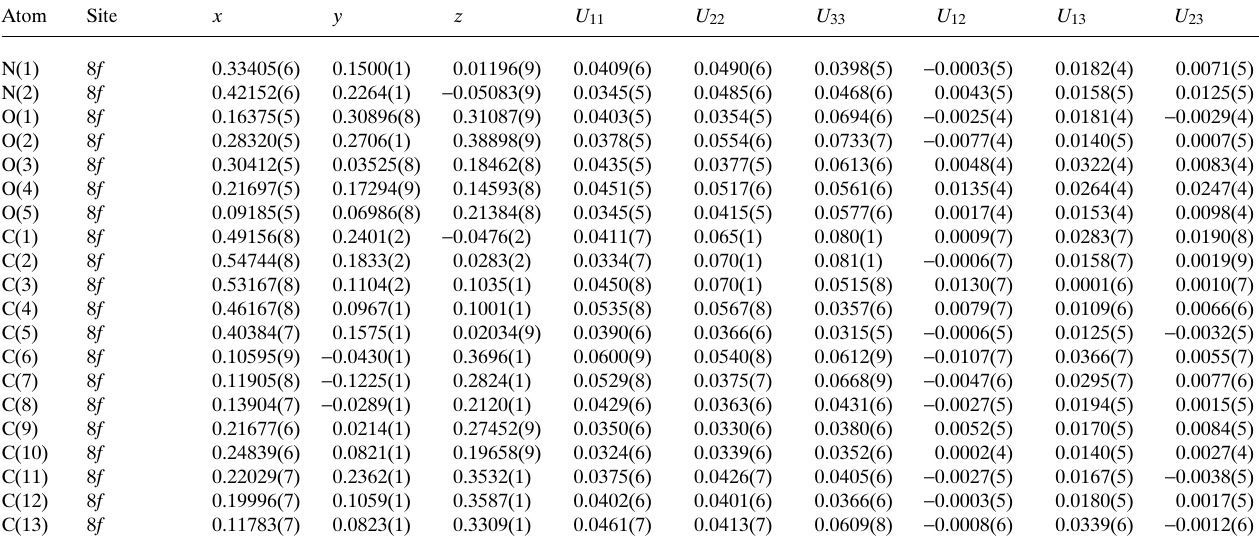
Table 3. Atomic coordinates and displacement parameters (in Å 2 ) .